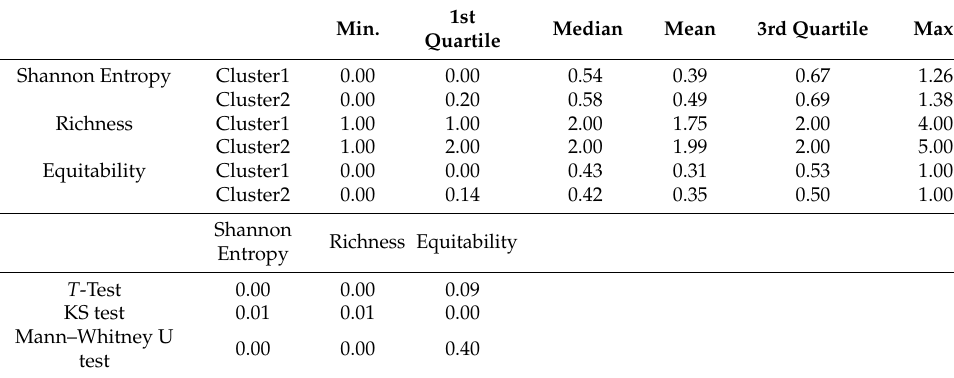
Table 5. Land use differences between the clusters.